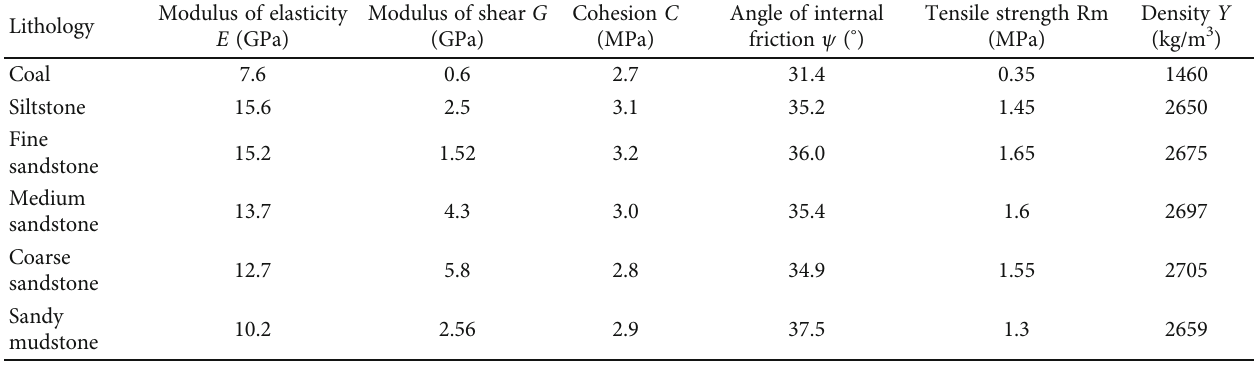
Table 2: Mechanical parameters of rock mass in the model.